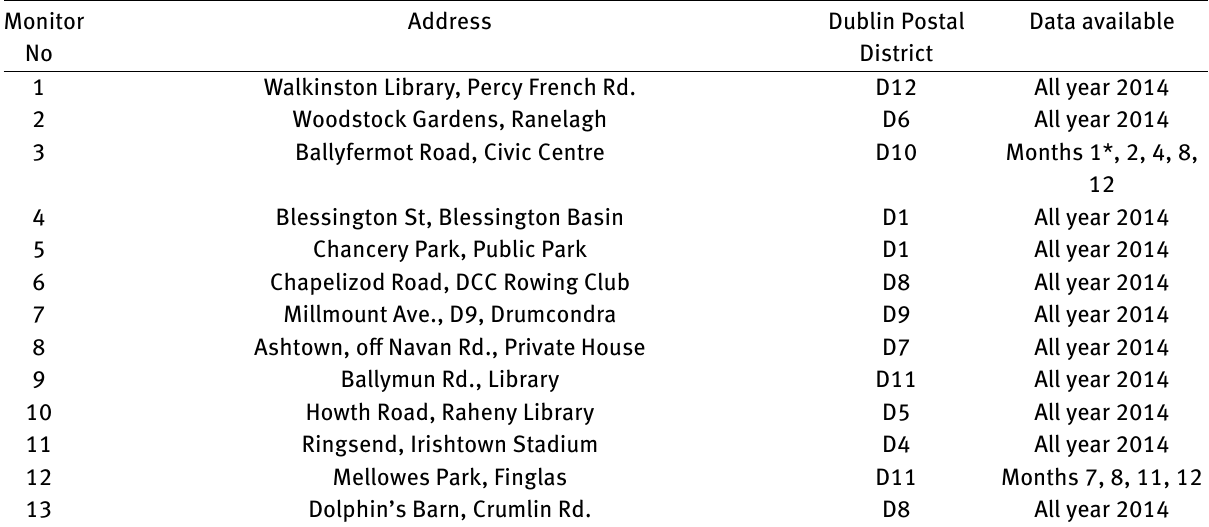
Supplementary Table 1: Summary of DCC measurement sites for model development